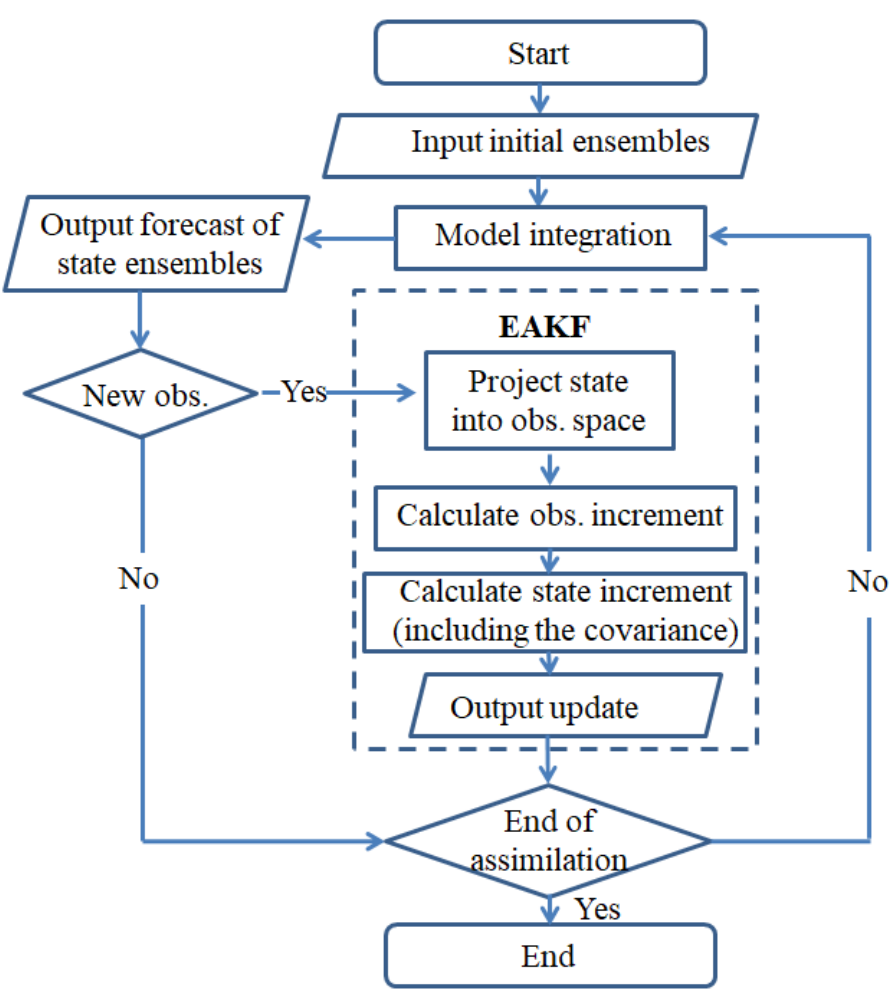
Figure 1. Flowchart of the data assimilation based on EAKF.